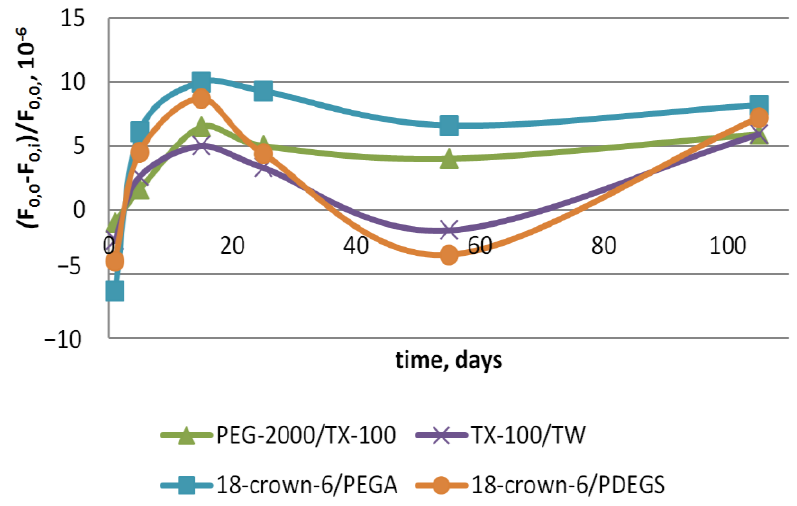
Figure 2. Dependence of relative shift of initial oscillation frequency ((F 0,0 − F 0,i )/F 0,0 ) of sensor with polycomposite coatings on day of analysis.